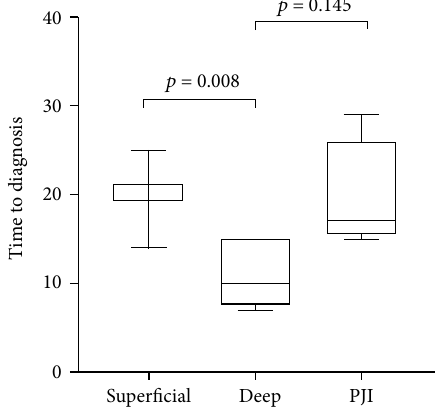
Figure 3: Time to diagnosis of surgical site infection (SSI) (days from the operation) in relation to the three classi fi cation categories of SSI (super fi cial, deep, and PJI) calculated by analysis of variance (ANOVA). Deep SSI was diagnosed signi fi cantly earlier than super fi cial SSI ( p = 0 : 008 ). This di ff erence loses statistical signi fi cance when comparing deep SSI and prosthetic joint infections (PJIs) ( p = 0 : 145